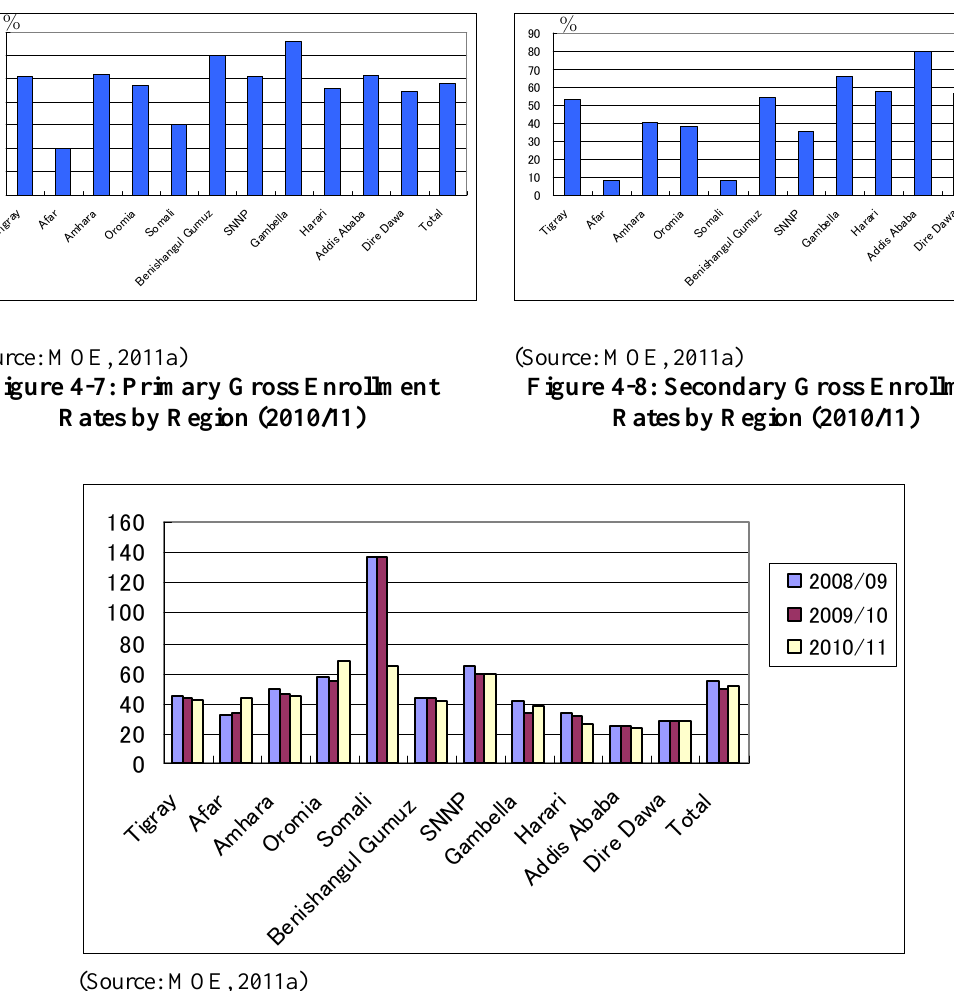
Figure 4-9: Primary Pupil Teacher Ratio by Region (2008/09 -